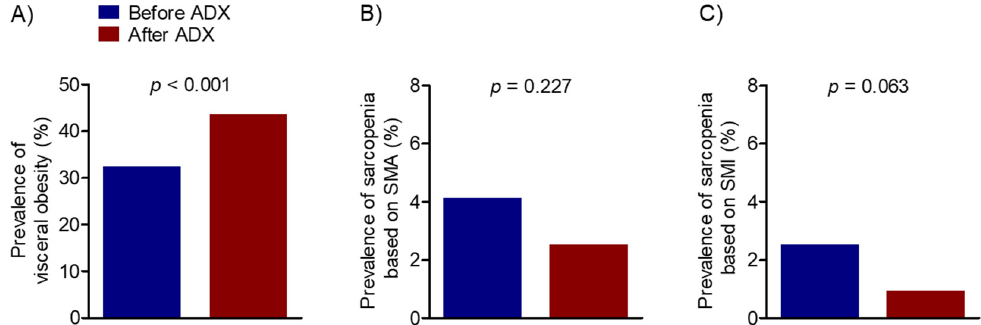
Figure 3. Changes in the prevalence of computed tomography-determined visceral obesity ( A ), sarcopenia based on skeletal muscle area ( B ), and skeletal muscle index ( C ) before and after adrenalec- tomy in patients with pheochromocytoma. All p -values were calculated using McNemar’s test for paired proportions. ADX, adrenalectomy; SMA, skeletal muscle area; SMI, skeletal muscle index. The associations of baseline catecholamine metabolites with changes in CT-based